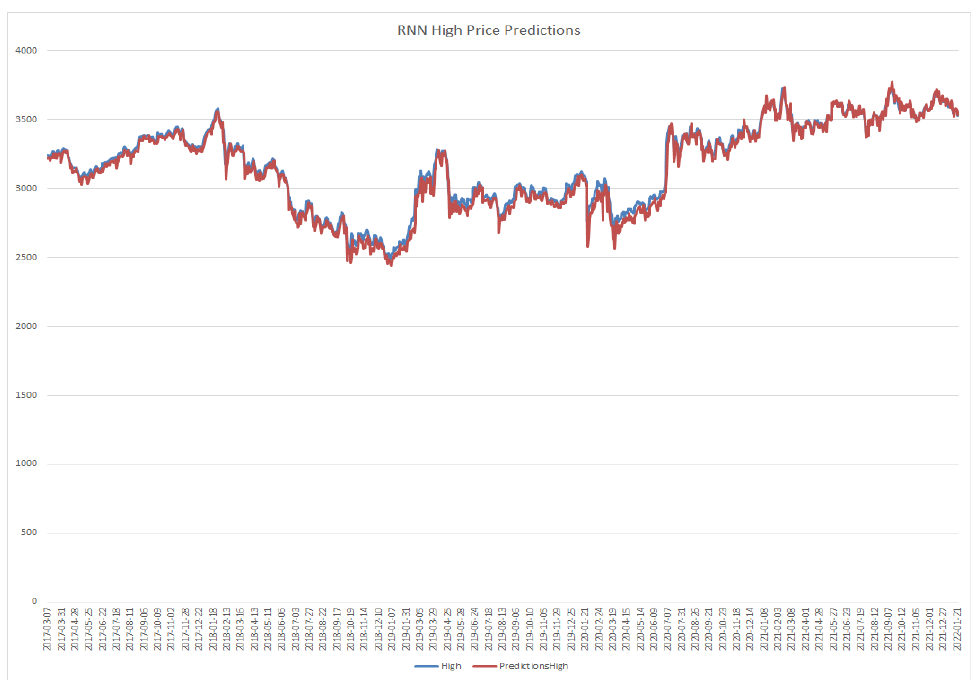
Figure 10. RNN model close price prediction.